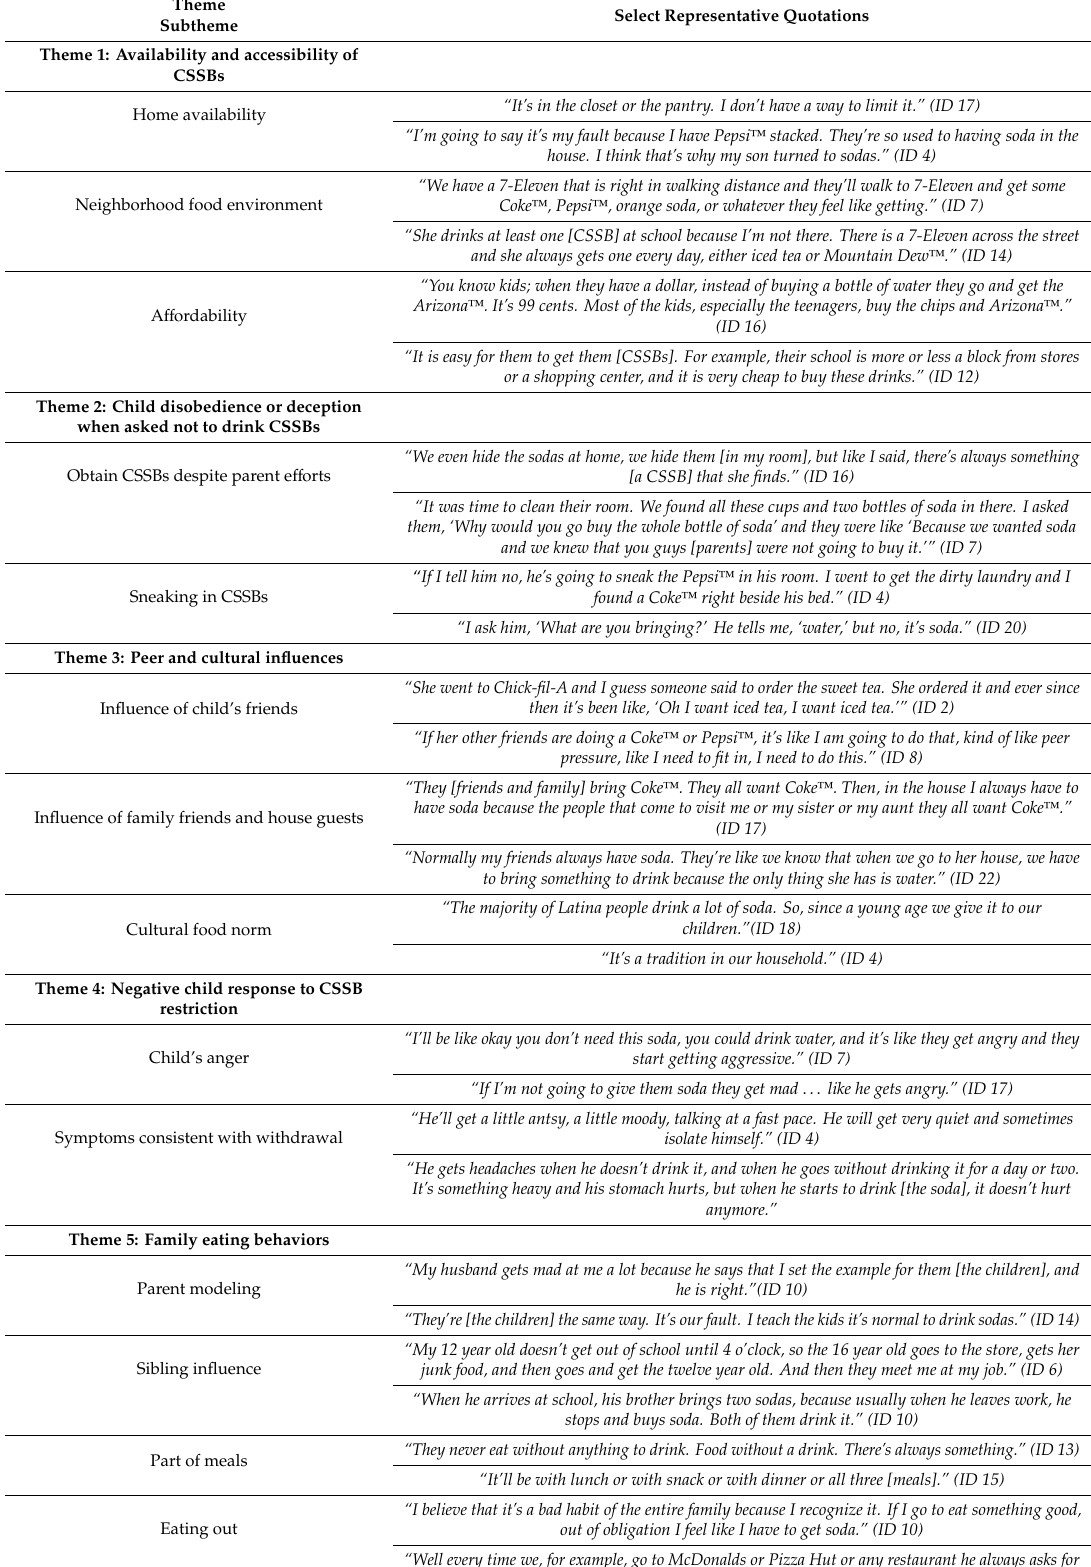
Table 4. Barriers to Restricting Ca ff einated Sugar-Sweetened Beverage (CSSB) Consumption among